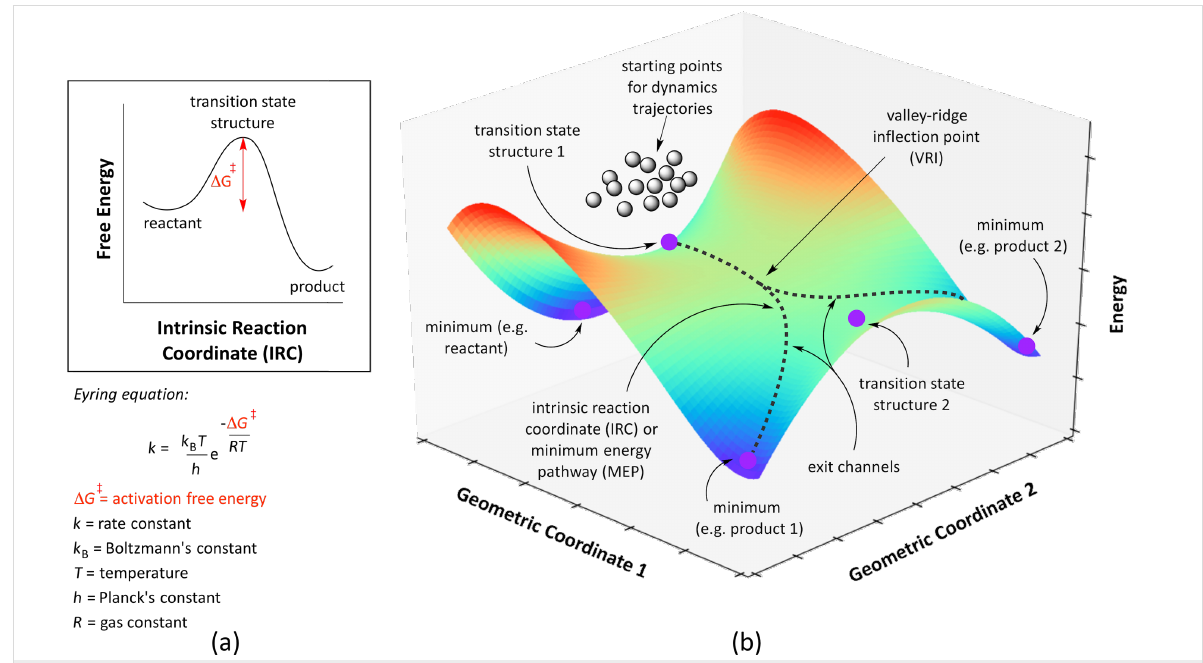
Figure 2: Two different models showing how energy evolves throughout the course of a reaction: (a) a two-dimensional plot, where the reactant follows a single path through the TSS to the product at a rate governed by the Eyring equation [9] and (b) a three-dimensional hypothetical PES ex- hibiting the features of a PTSB and a qualitative representation of the starting points for dynamics trajectories. The function z = 2x 5 − 5x 2 − 5xy + y 2 + 2 was used to generate this hypothetical surface.